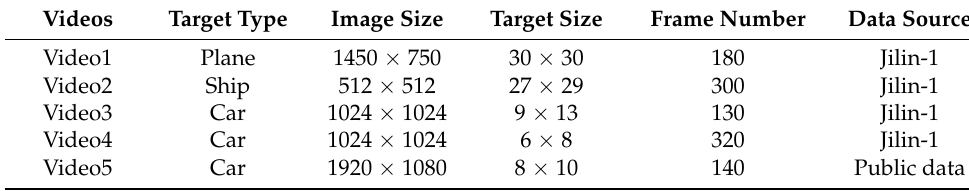
Table 2. The detail information about the datasets.